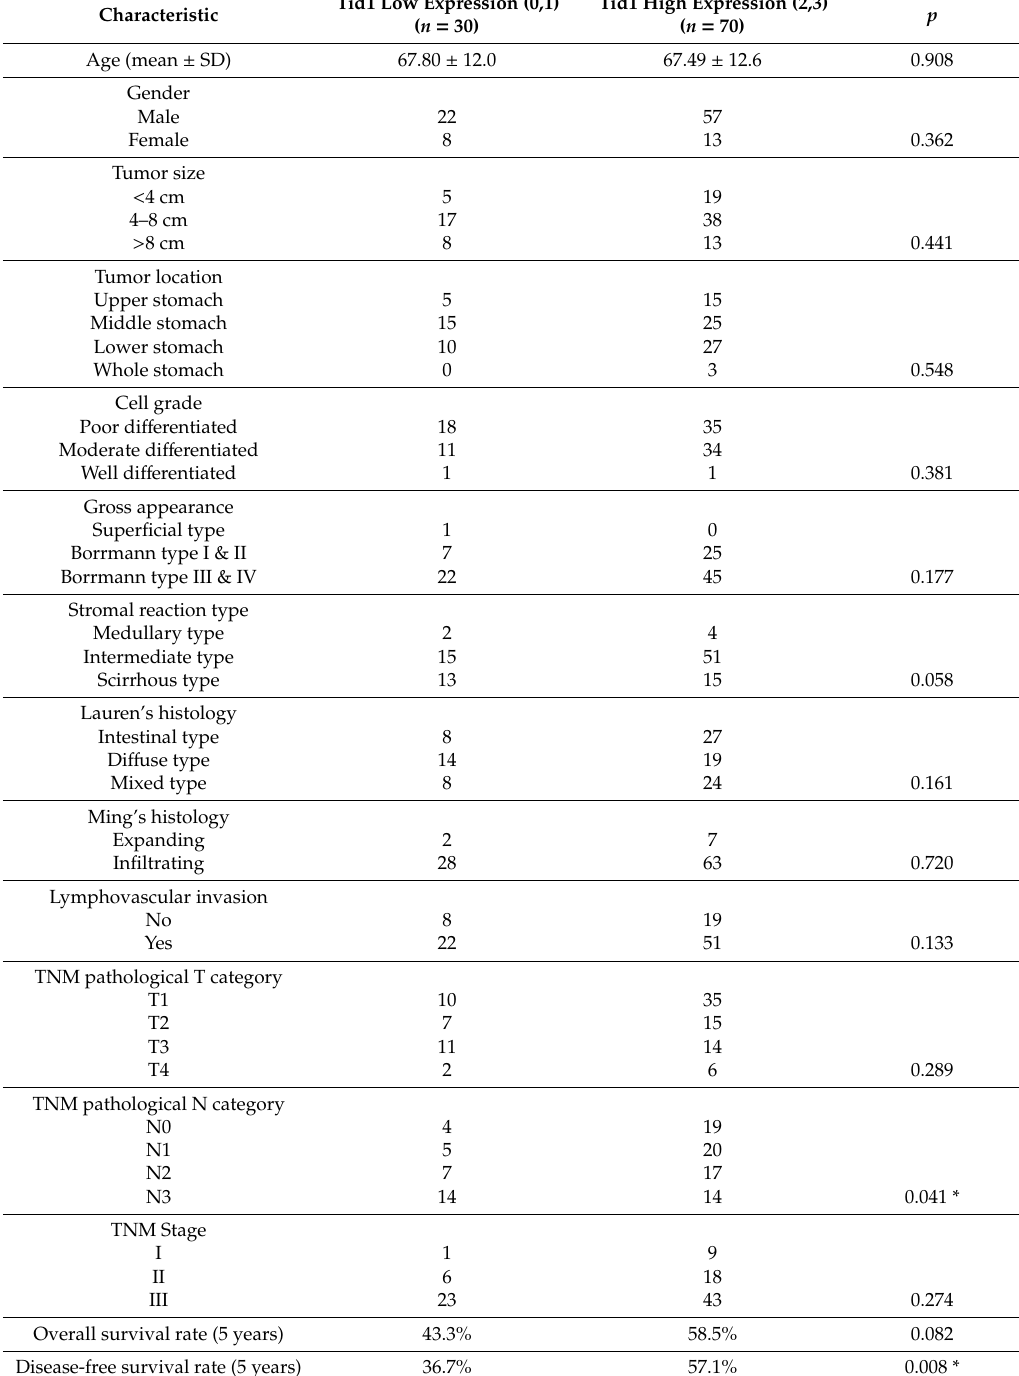
Table 1. Clinical profiles of 100 gastric cancer patients with low or high Tid1 expression in tumors.